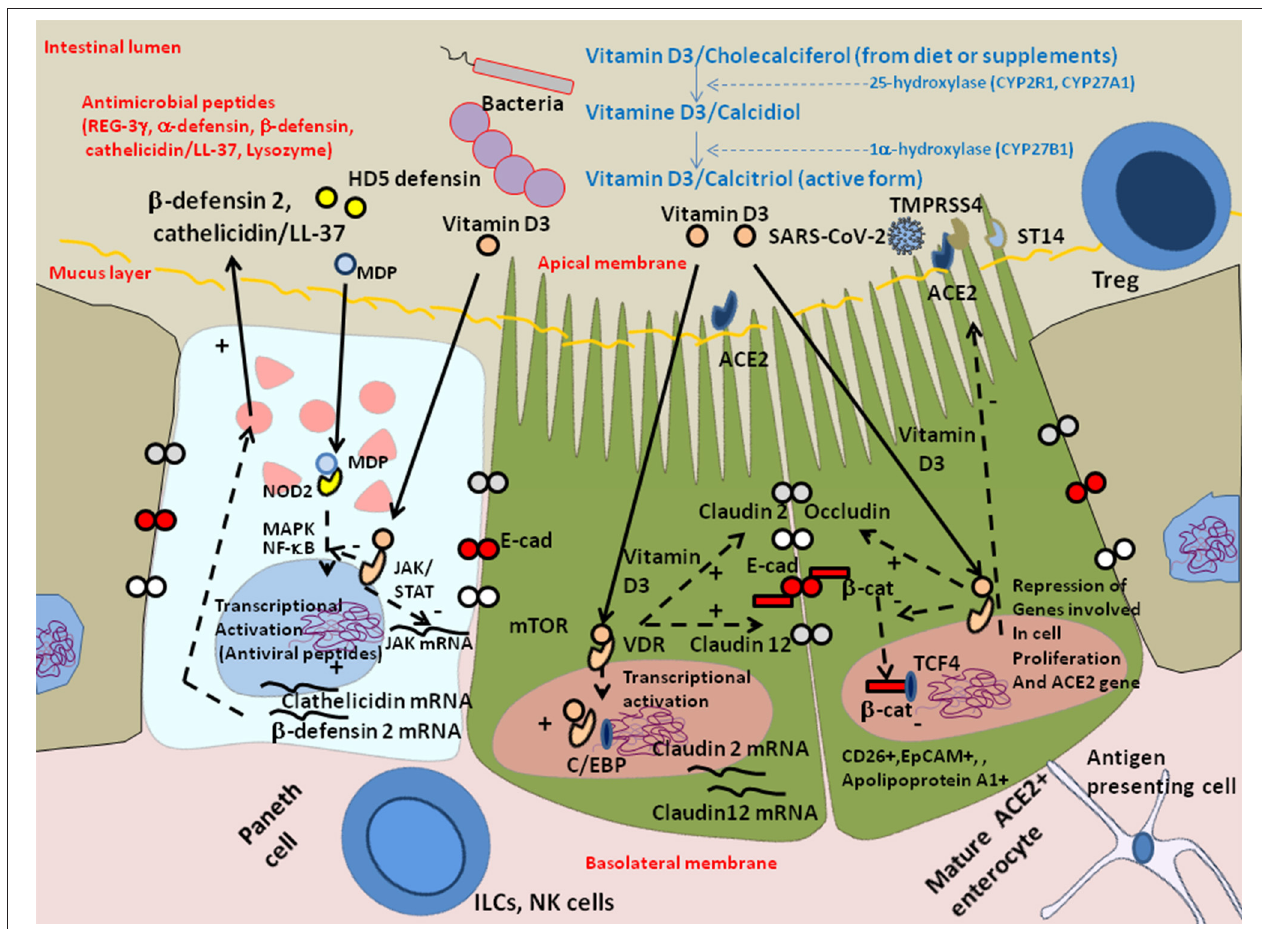
FIGURE 6 | Schematic representation of the protective effect of Vitamin D against dysbiosis and its proinflammatory effects. Vitamin D/cholecalciferol from diet or supplements is hydroxylated to 25-hydroxy-vitamin D or calcidiol by the cytochrome P450 hydorolases CYP2R1 and CYP27A1, then it is hydroxylated at the 1 alpha position by CYP27B1 to generate calcitriol which is the metabolically active form of vitamin D3. Vitamin D receptor (VDR) maintains the Paneth cell alertness to pathogens in intestinal disorders. The Paneth cells produce antimicrobial proteins (e.g., C-type lectin REG3 γ , α -defensins, β -defensins, cathelicidins, and lysozyme) in response to infection. Genetically and environmentally regulated VDR in the Paneth cells may set the threshold for the development of chronic inflammation. Vitamin D3/VDR upregulates cathelicin/LL-37 and β -defensin 2 and downregulates the JAK/STAT and NF-kB pathways. In the presence of Vitamin D3, the VDR expressed in enterocytes translocates to the nucleus where it cooperates with the C/EBP transcription factor to increase Claudin 2 and Claudin 12 gene transcription, increasing the pools of cytoplasmic Claudins, two molecules that contribute, together with E-cadherin (E-Cad), to the integrity of epithelial tight junctions. The activation of VDR by vitamin D3 also suppresses the cytoplasmic release of β -catenin from E-cad thus decreasing the levels of nuclear β -catenin and reducing the levels of β -catenin/T cell factor (TCF) complexes that are required for the expression of genes involved in cell proliferation (such as cyclin D). Symbols: ( + ) means activation; (–) means: